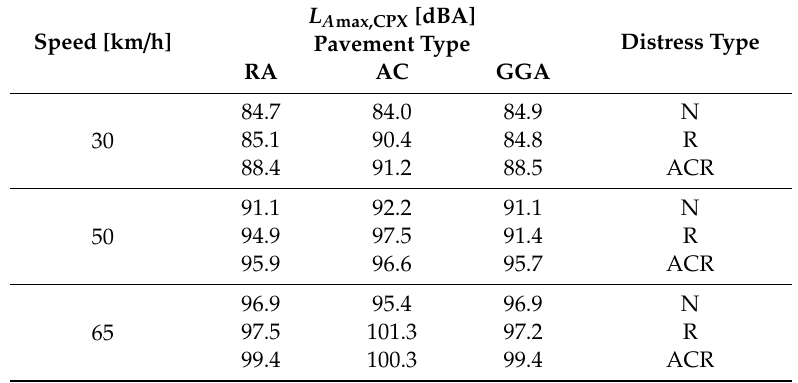
Table 3. Measured L A max,CPX [dBA], according to the speed, pavement and distress